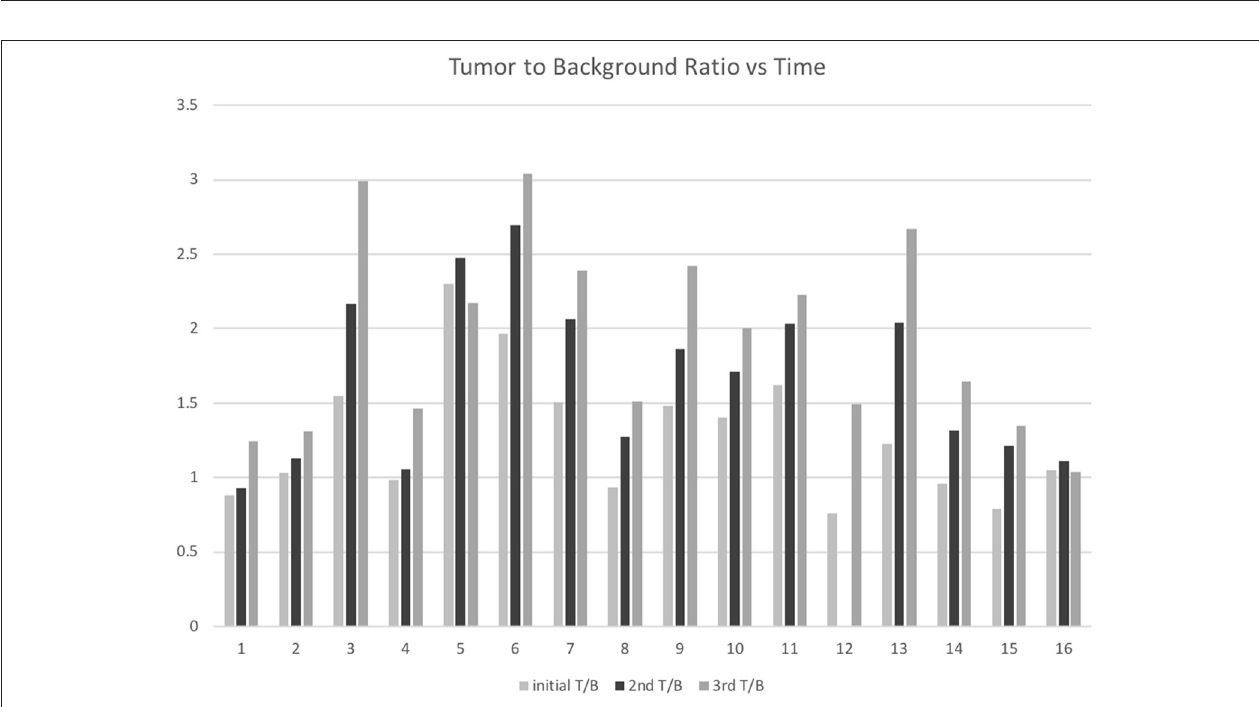
FIGURE 2 | F18-FDG tumor to background ratios 1-, 5-, and 8-h following F18-FDG injection in 16 patients with IDH-wild type, glioblastoma.